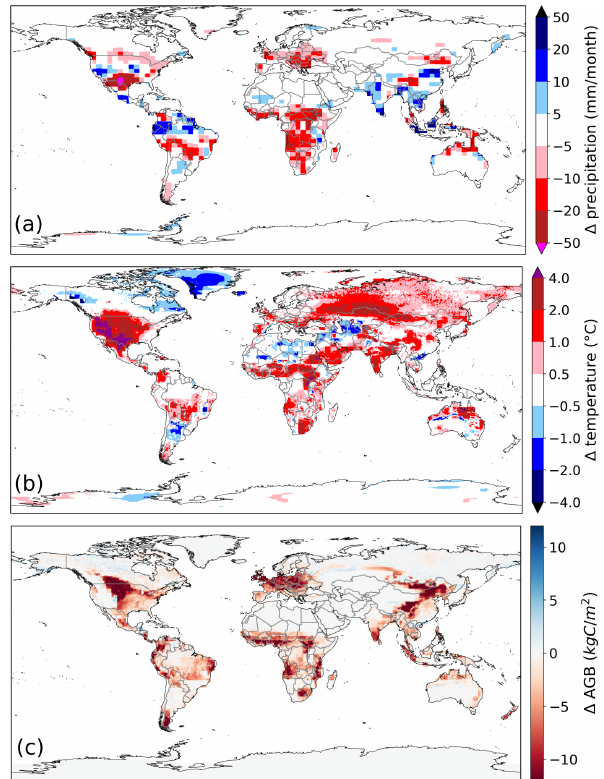
Figure 10. Difference between the LU-only (2006–2015) and the pi-Control (last 10 years) experiments for (a) mean precipita- tion, (b) mean surface air temperature and (c) mean aboveground